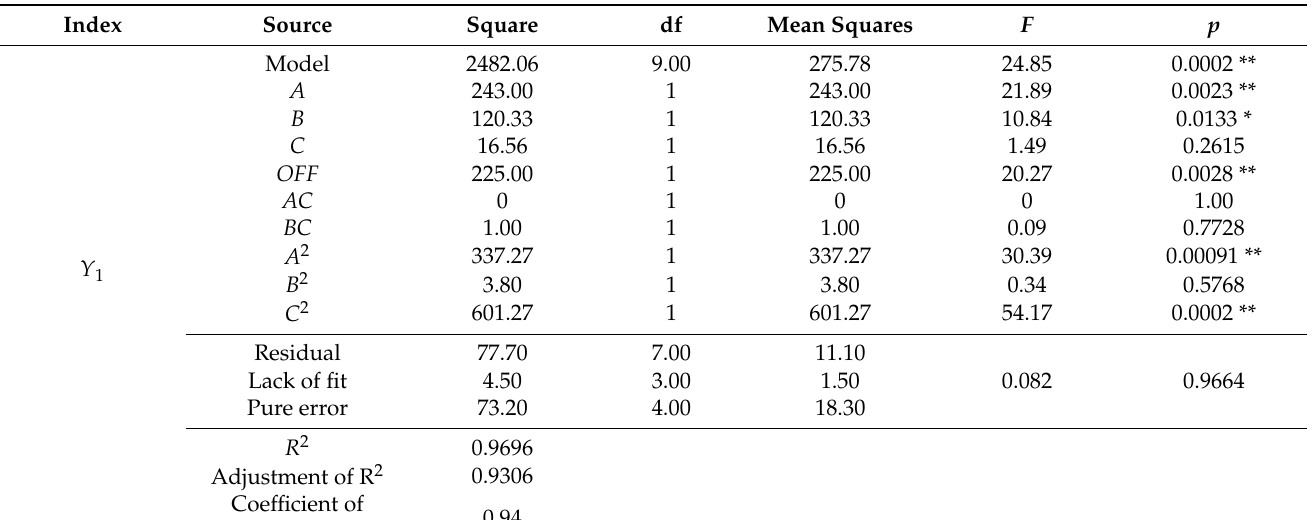
Table 3. Variance analysis of harvest